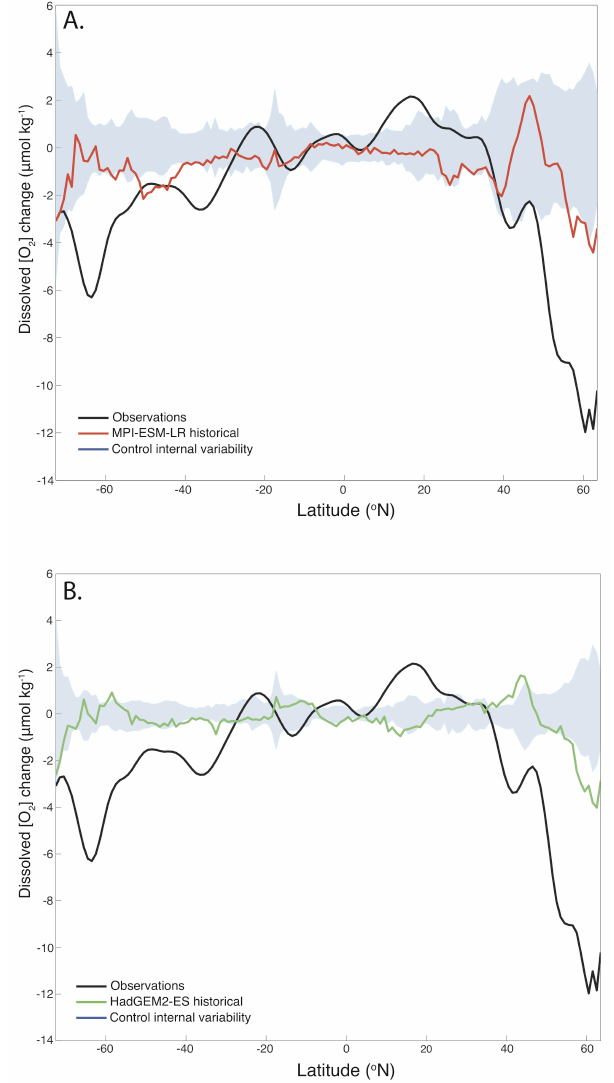
Fig. 7. Observed (black) and simulated (red or green) patterns provided to the 1-D optimal detection as zonal mean [O 2 ] changes (µmolkg − 1 ) averaged between 100–3000m depth using MPI-ESM-LR (A) and HadGEM2-ES (B) historical experiments. The spread of internal variability (shown by the shaded area) is estimated by sampling model piControl simulations, as described in Sect. 2.2.